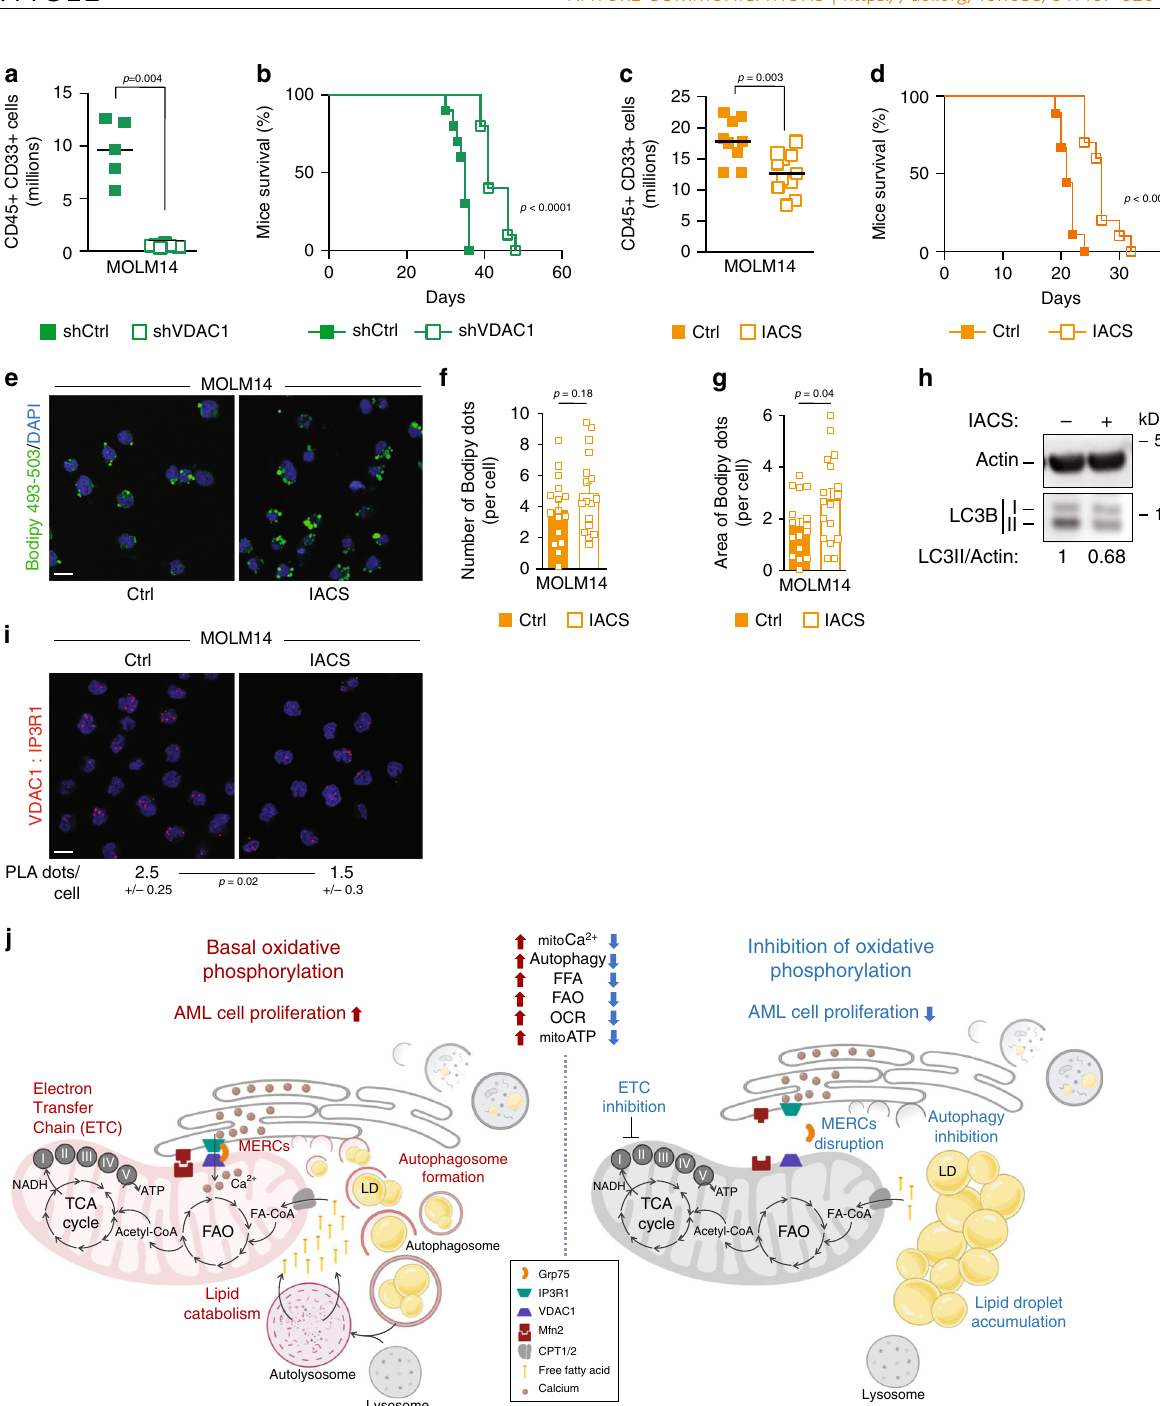
(KH95), from Millipore against actin, rabbit antibody from Abcam against VDAC1 (ab15865), from PROGEN against ADRP (610102), from R&D System against FABP4 (AF3150), from Atlas Antibodies against ACLY (HPA022434), from Novus Biologicals against SREPB1 (NB600-582), from Invitrogen against SREBP2